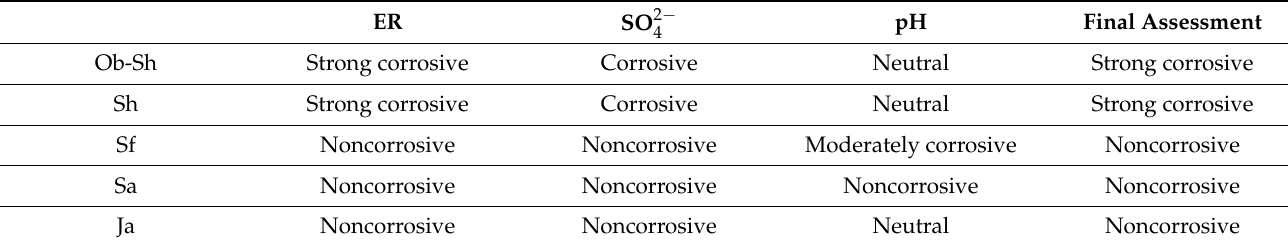
Table 6. Relationship between soil variables (ER, SO 2 −